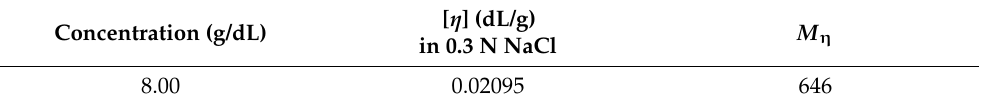
Table 1. Results of the calculation of the intrinsic viscosity [ η ] and molecular weight M η of the PHMG oligomer. The used Mark–Houwink–Sakurada parameters K and α have been found in literature [35].